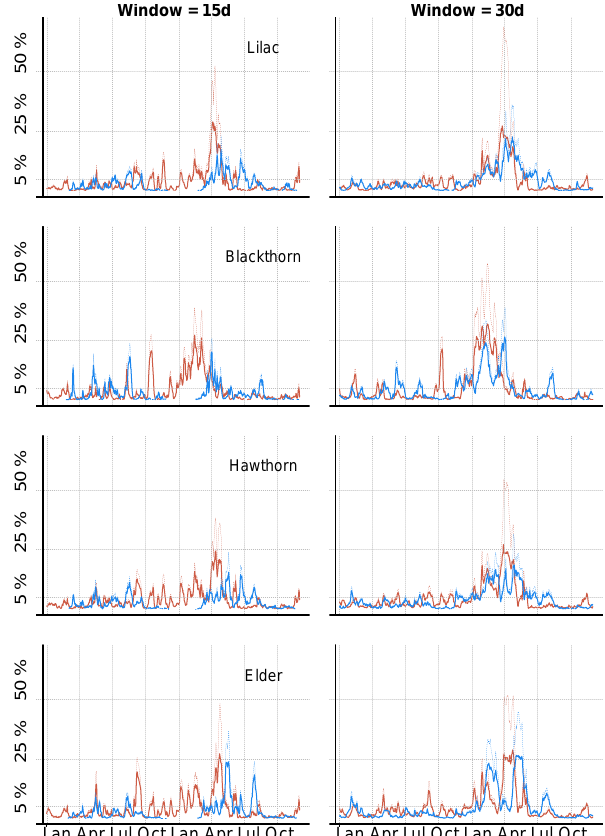
Figure 5. Fraction of stations with significant coincidence rates be- tween extreme flowering dates and extreme window-mean tempera- ture for the four shrub species and two different window sizes. The x axes refer to the starting date of a window; the y axes denote the percentage of stations that show significant coincidence rates for the specific window. Red (blue) lines refer to coincidences of extreme warm (cold) temperatures with extreme early (late) flower- ing at confidence levels of α = 0 . 05 (solid) and α = 0 . 01 (dotted),